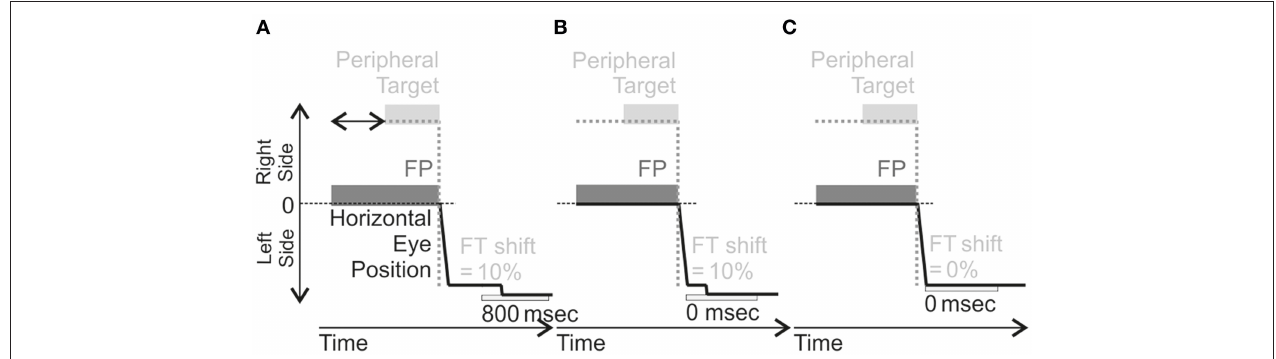
FIGURE 4 | Schema of AS training in the different training. These illustrations are for Left-HVFD patients (leftward AS elicited by a target in the right visual field). For each training, the Fixation Point (FP) is first presented, followed by a peripheral target appearing between 1100 and 1500ms (horizontal black arrow represented in A) after FP presentation, located on the right. In the Delayed-Shift training ( A ), the feedback target (FT) is presented 800ms after AS completion at a location shifted outward by 10% of the anti-saccade amplitude. In the Adaptation training ( B ), the FT is also presented at the shifted location (same 10% offset) but at the time of anti-saccade completion (0ms). In the No-Shift training ( C ), the FT is presented without delay from anti-saccade completion (0ms) but also without offset, i.e., at the mirror position of the peripheral target. For Right-HVFD patients, the training was similar except that the peripheral target was now presented on the left side and anti-saccades performed to the